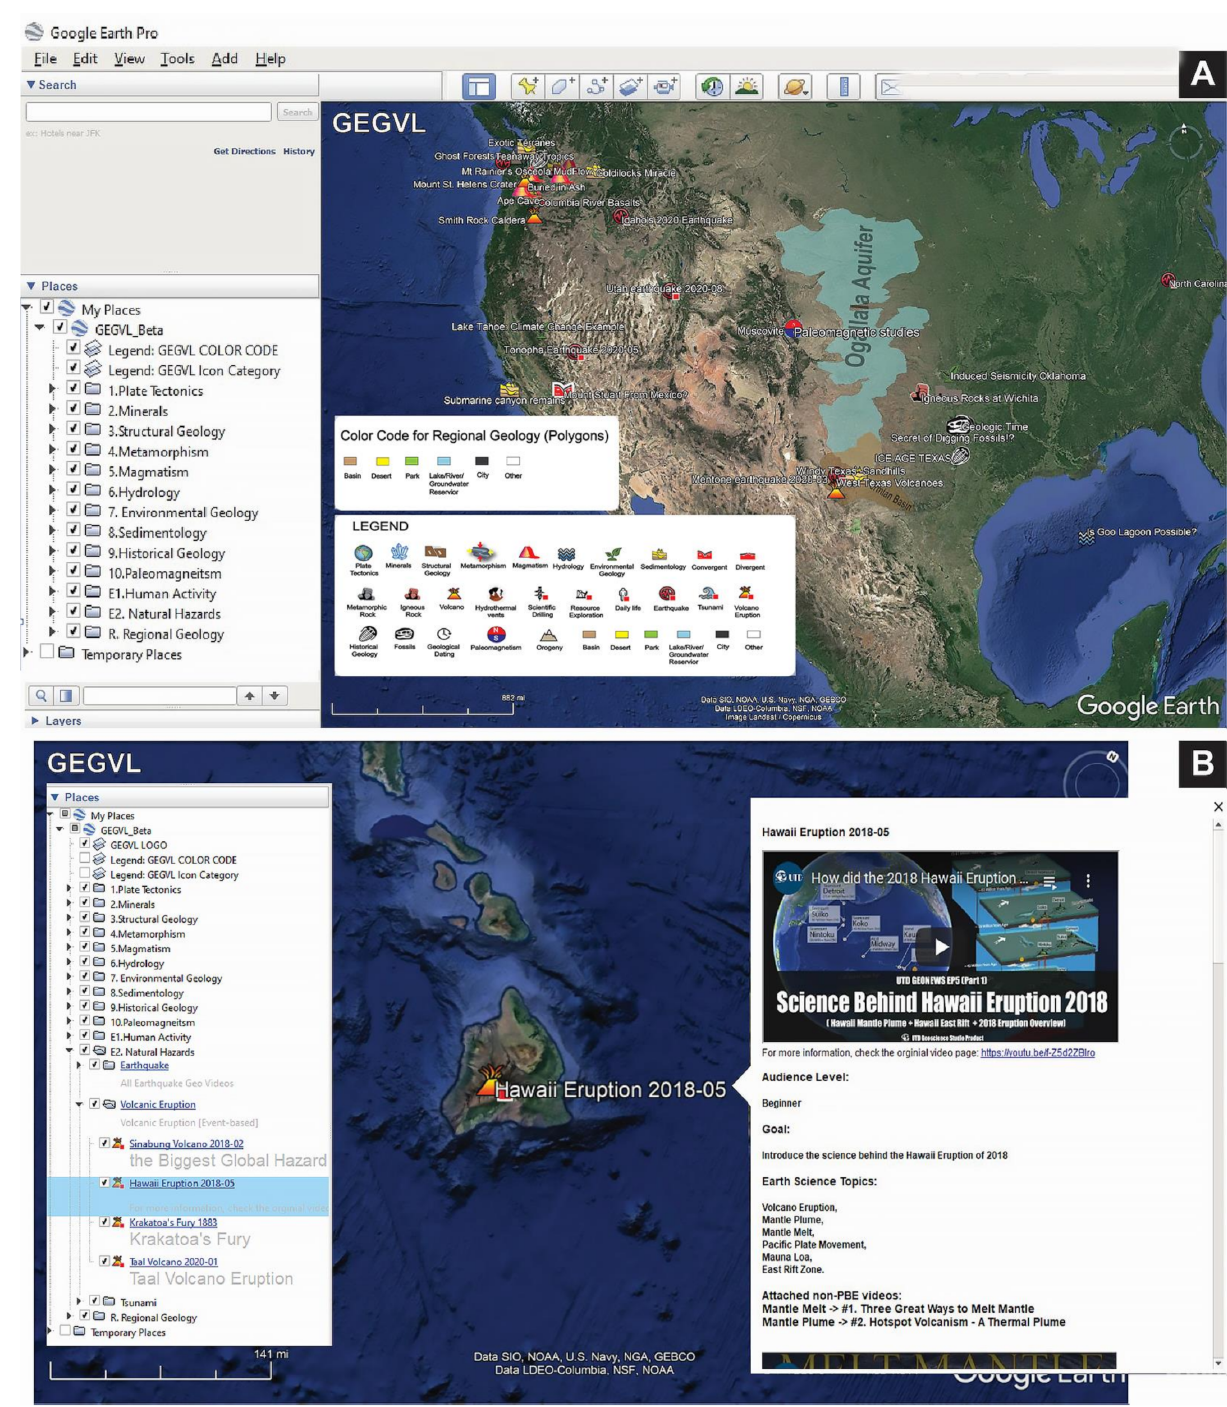
Figure 3. Demonstration of GEGVL panels: ( A ) GEGVL operation panel; ( B ) an example of GEGVL popup page for the “Hawaii Eruption 2018-05”